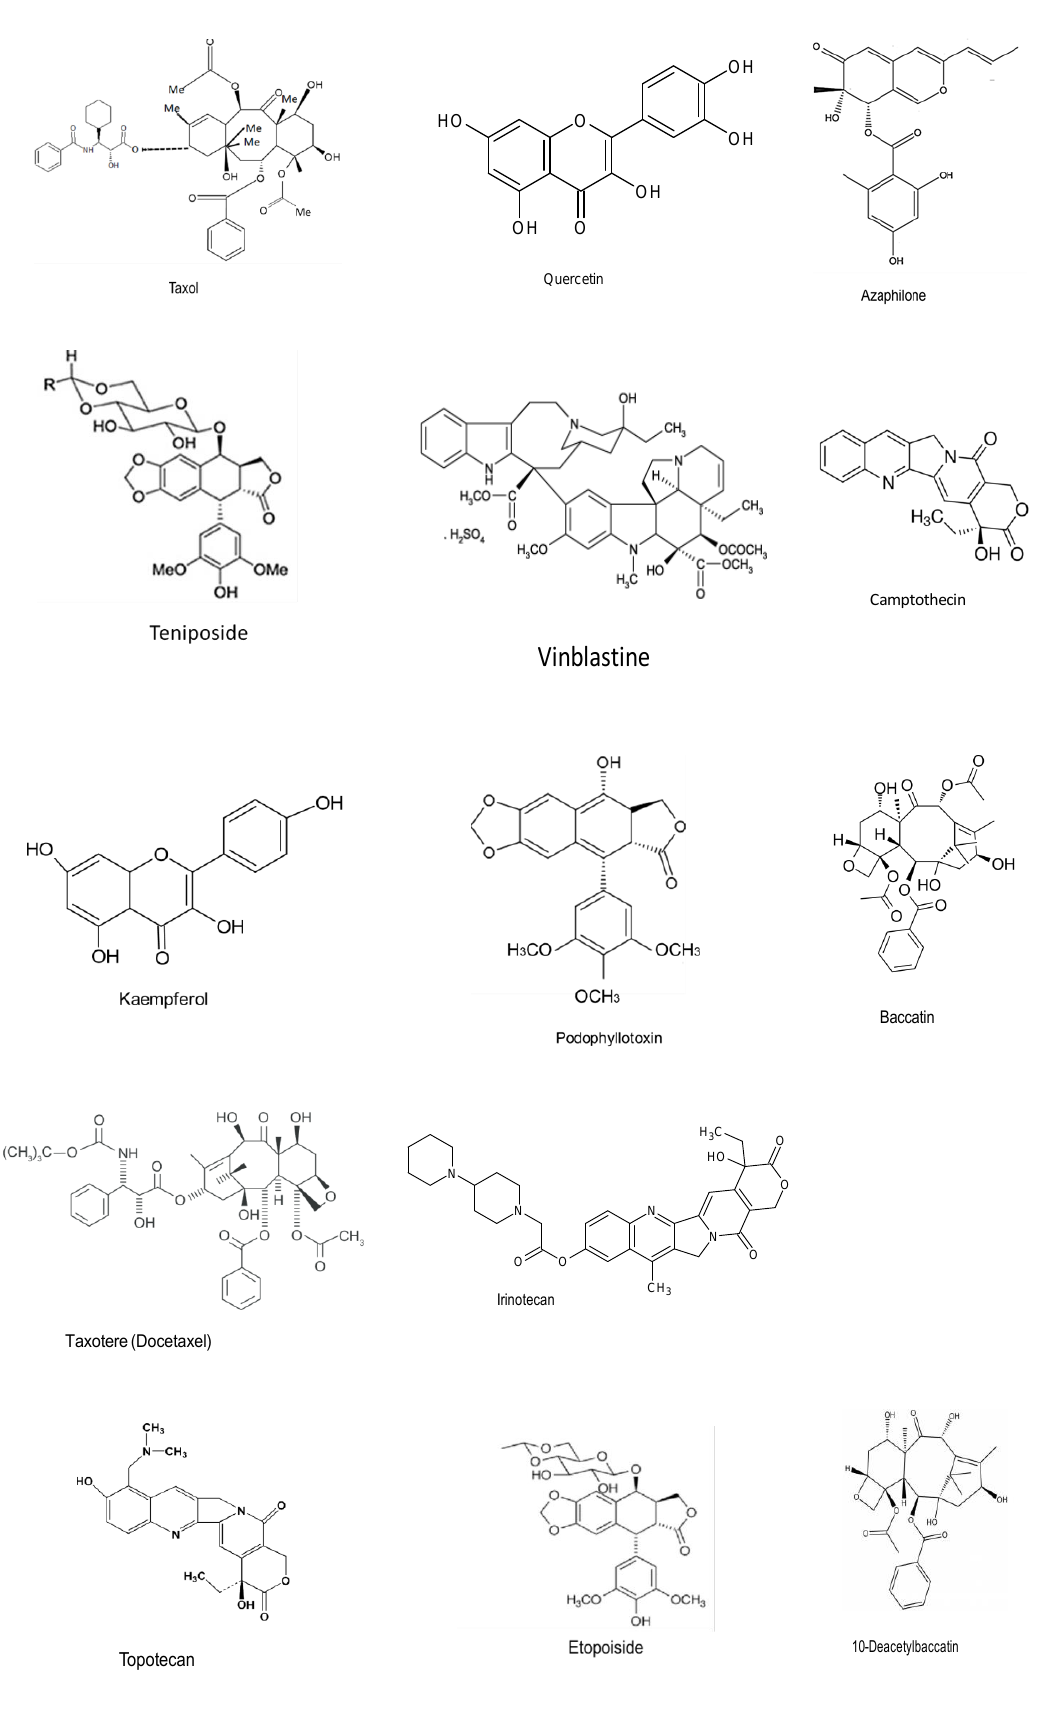
Figure 4. Chemical structures of the bioactive compounds with anticancer activities [25,44,54].